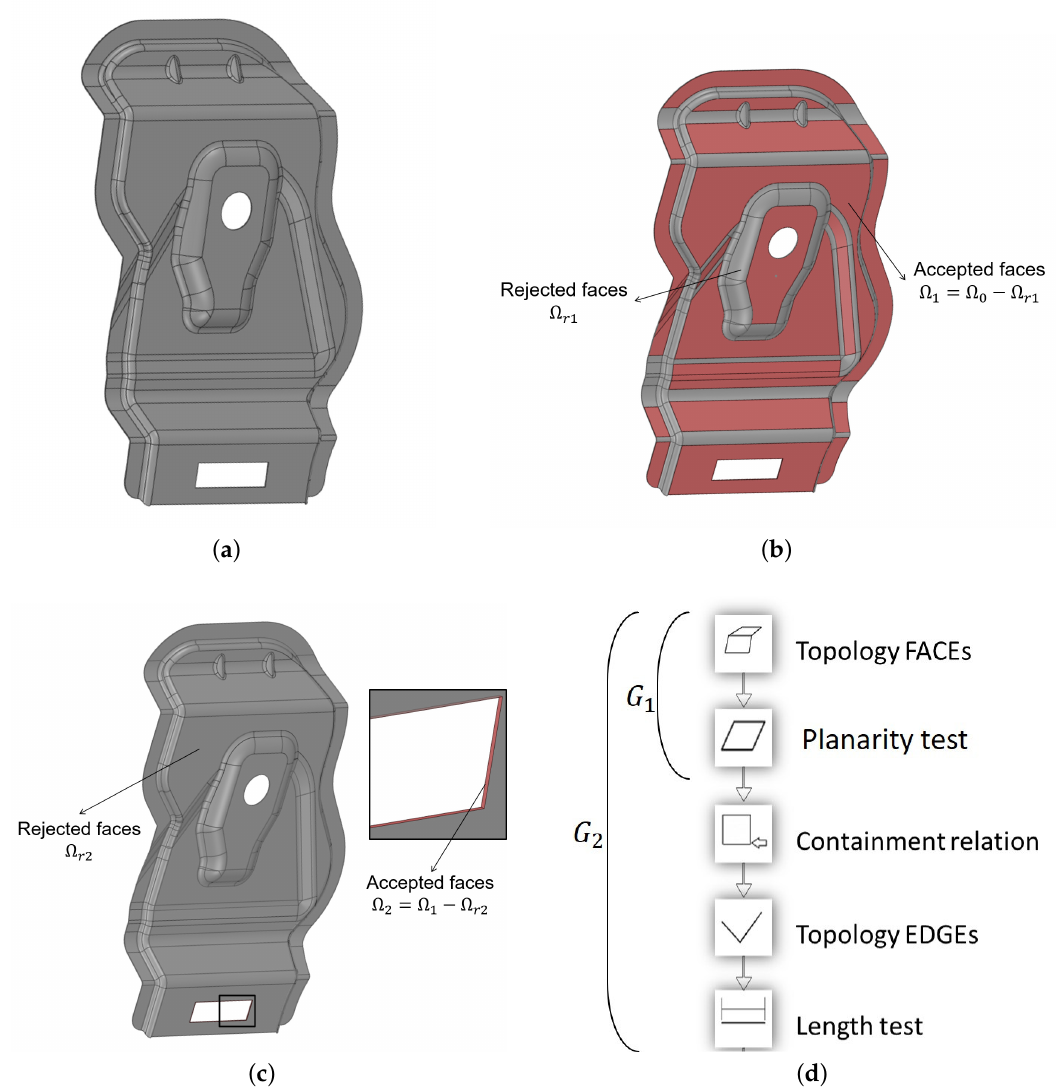
Figure 16. Results of Example 3: recognition of square hole feature in data set 3. ( a ) Initial data set Ω 0 , ( b ) Reduced domain Ω 1 ⊂ Ω 0 , ( c ) Reduced domain Ω 2 ⊂ Ω 1 , and ( d ) Search graphs G 1 and G 2